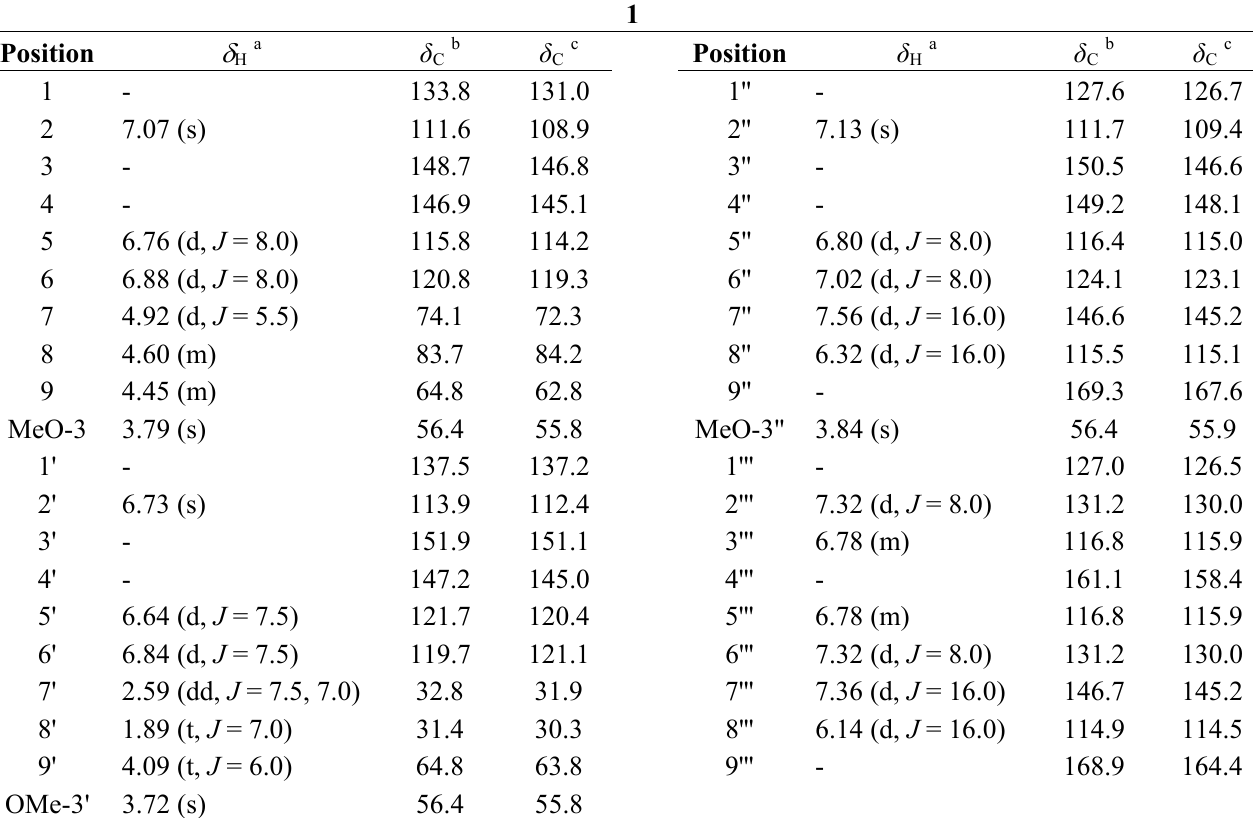
Table 1. 1 H-NMR and 13 C-NMR spectroscopic data (  in ppm, J in Hz) of compound 1